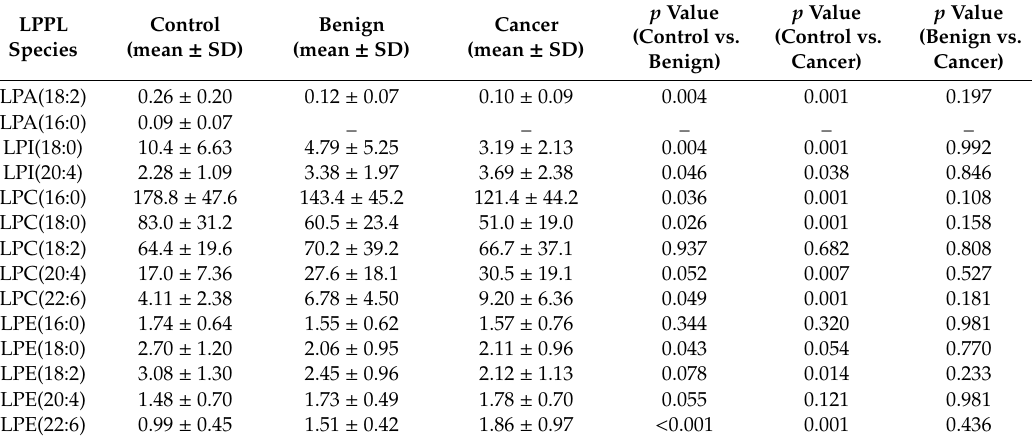
Table 1. Lysophospholipids (LPPL) ( µ mol / L) in control, patients with benign ovarian tumor, and patients with ovarian cancer groups ( n = 18 for control, n = 23 for benign, n = 20 for